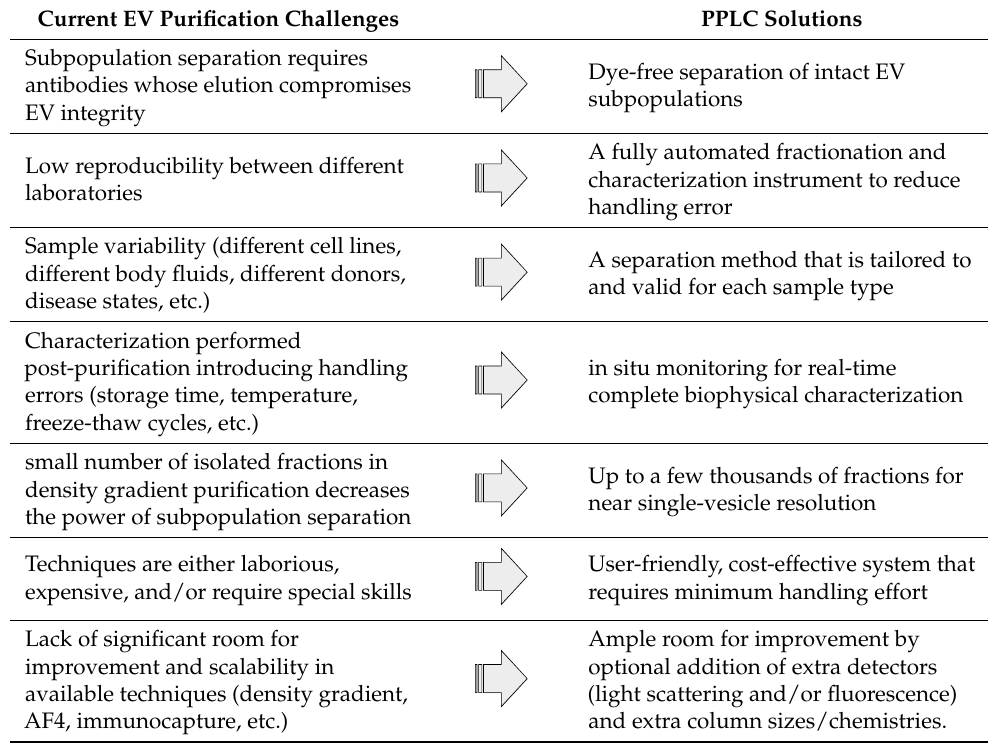
characterization instrument to reduce